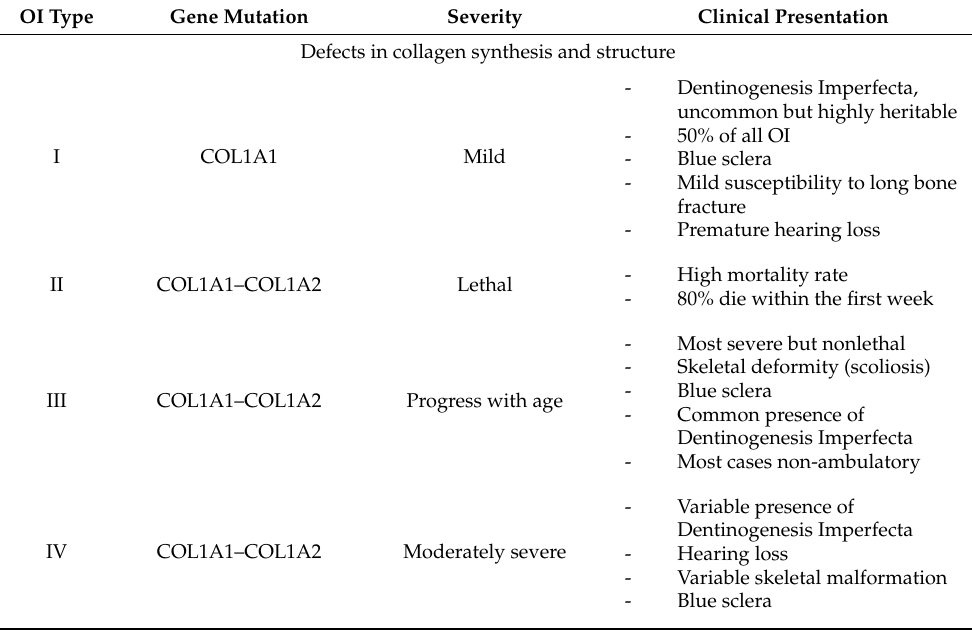
Table 1. Updated classification of osteogenesis